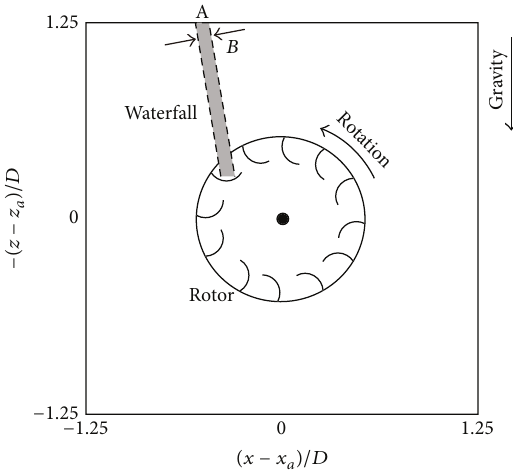
Figure 3: Computational